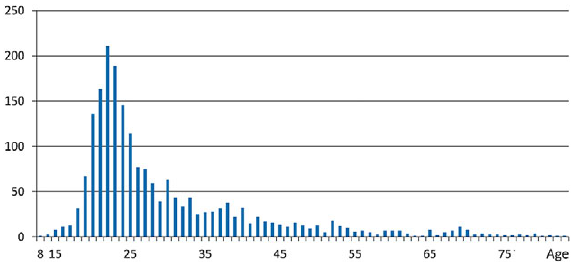
Fig. 7. Age distribution of respondents in Olomouc (by J.